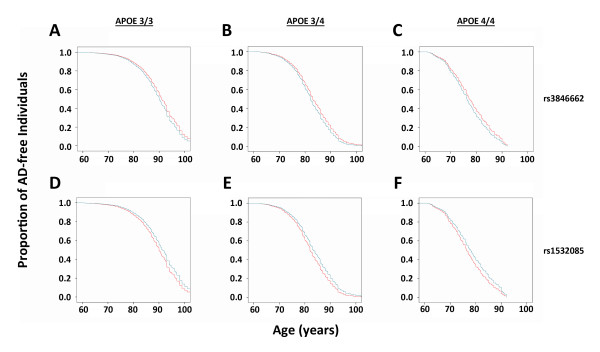
Both rs3846662 and rs1532085 are significantly associated with AD age-of-onset. (A-C) Carriers of the rs3846662_G allele exhibit a significantly earlier onset of AD than AA homozygotes, stratified by the number of APOE-ε4 alleles present. (D-F) Individuals homozygous for the A allele of rs1532085 exhibit a significantly later onset of AD than carriers of the G allele, again stratified by the number of APOE-ε4 alleles present. (A/D - no APOE-ε4, B/E - 1 copy of APOE-ε4, C/F - 2 copies of APOE-ε4)